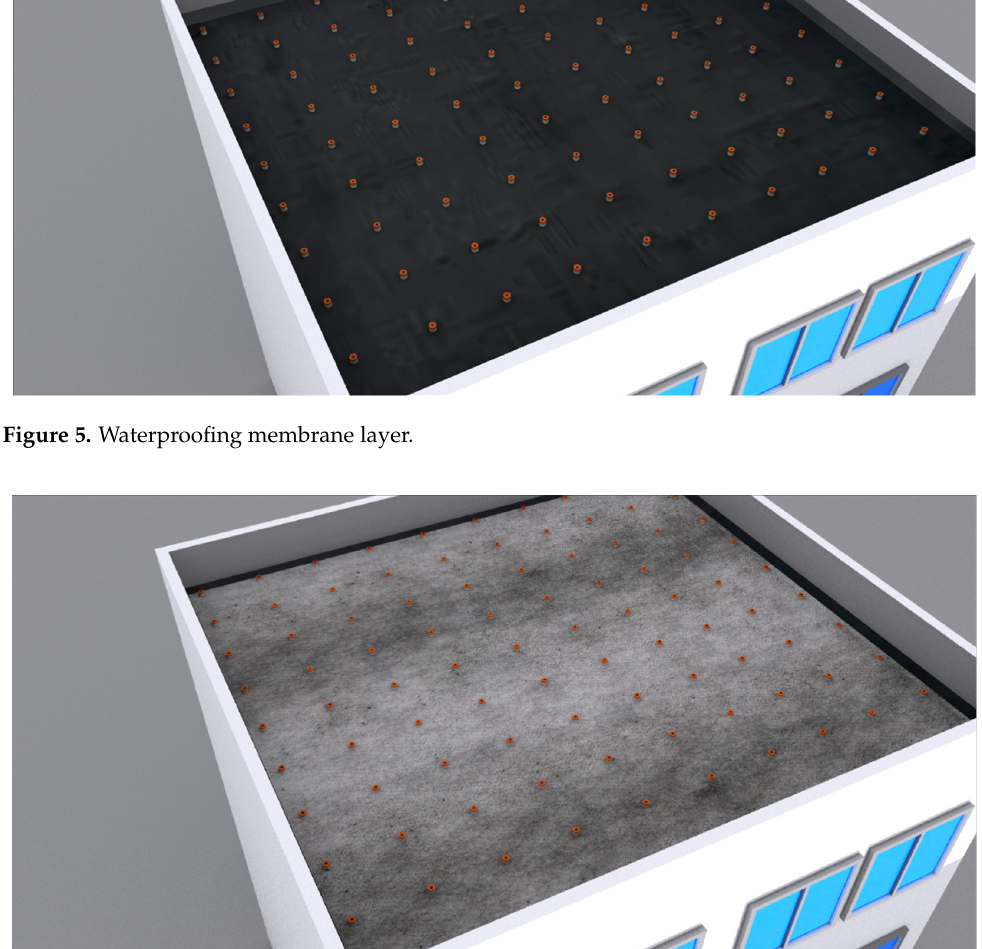
Figure 6. Root barrier or anti-root layer (on the top of the waterproofing membrane layer).